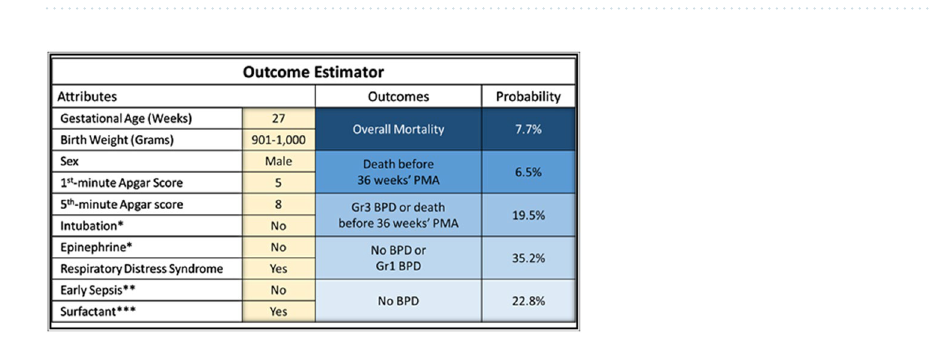
Table 5. Intercept and coefficient values of the attributes in various models developed using logistic regression. BPD Bronchopulmonary dysplasia; BW Birth weight; GA Gestational age; Gr Grade; PMA from a blood sample and/or a cerebrospinal fluid sample obtained on day 1, 2, or 3 of life. ***Exogenous surfactant administrated at any time and through any pathway.